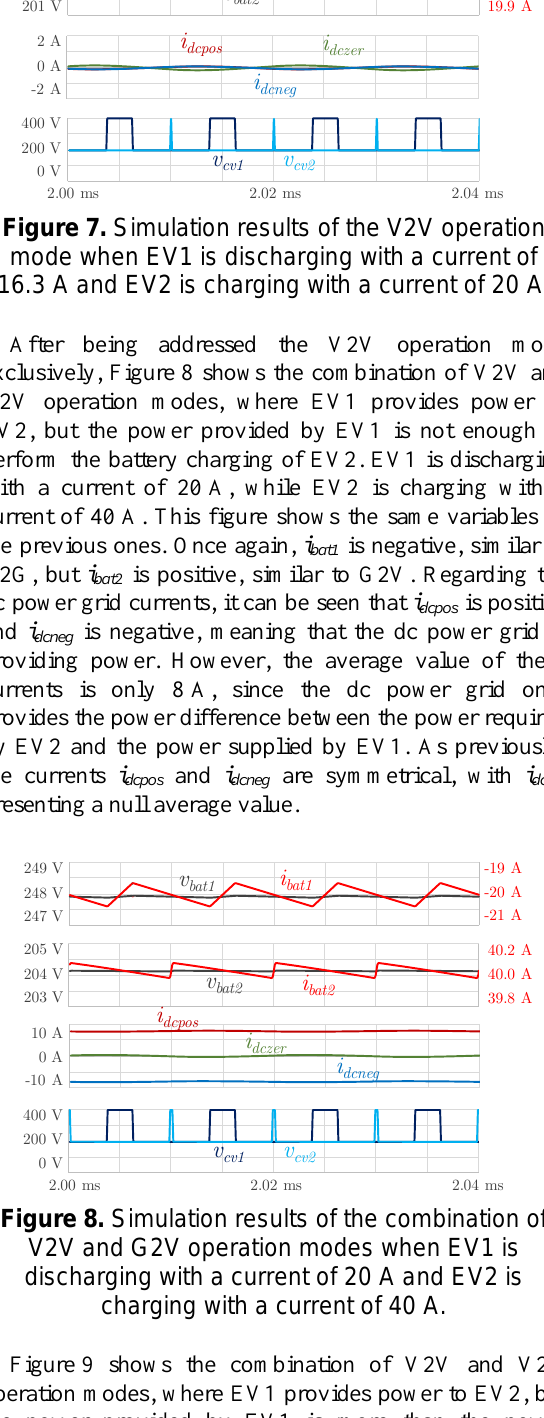
Figure 8. Simulation results of the combination of V2V and G2V operation modes when EV1 is discharging with a current of 20 A and EV2 is charging with a current of 40